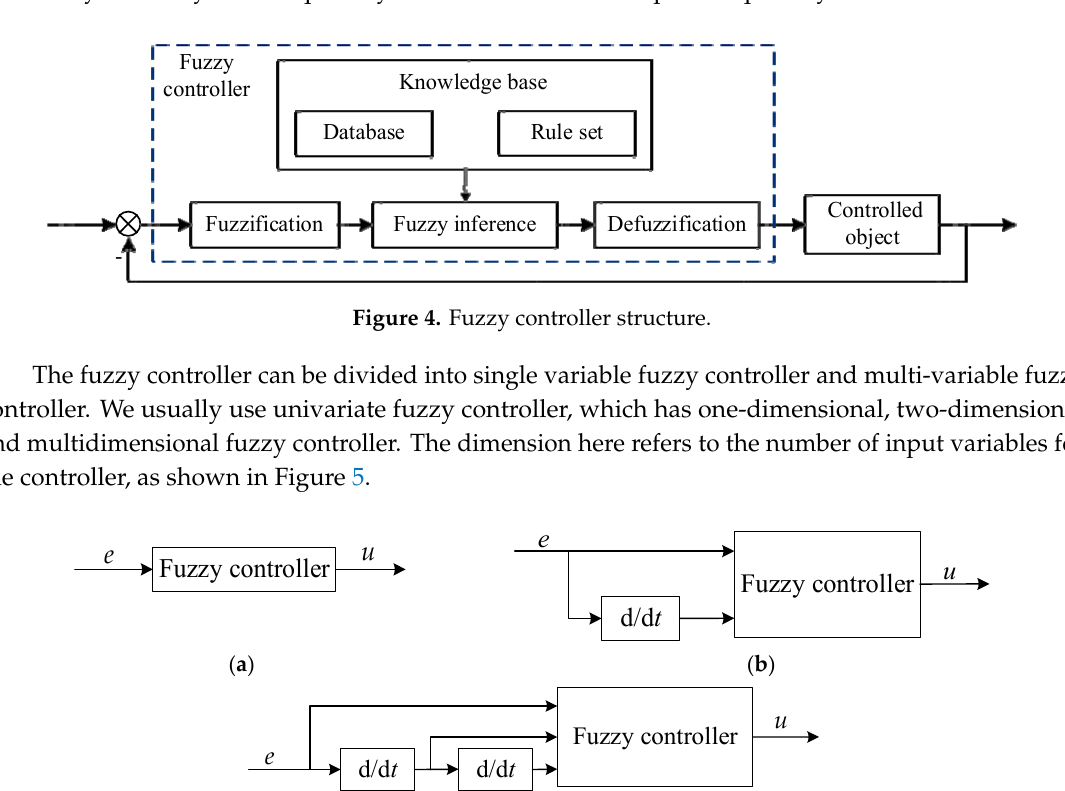
u yK I Figure 6. fuzzy controller with different dimensions. In order to improve the response speed of the control system, an improved fuzzy controller is used in the WECS. The controller originally controlled the three parameters